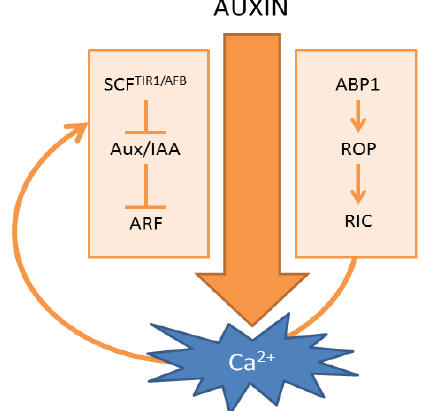
Figure 1. Scheme of auxin-induced Ca 2+ signals. ( Left ) Canonical SCF TIR1/AFB -mediated auxin signaling; ( Right ) ABP1-mediated auxin signaling. The curved arrow represents a hypothetical model in which Ca 2+ acts as a connecting signal between ABP1 and SCF TIR1/AFB signaling